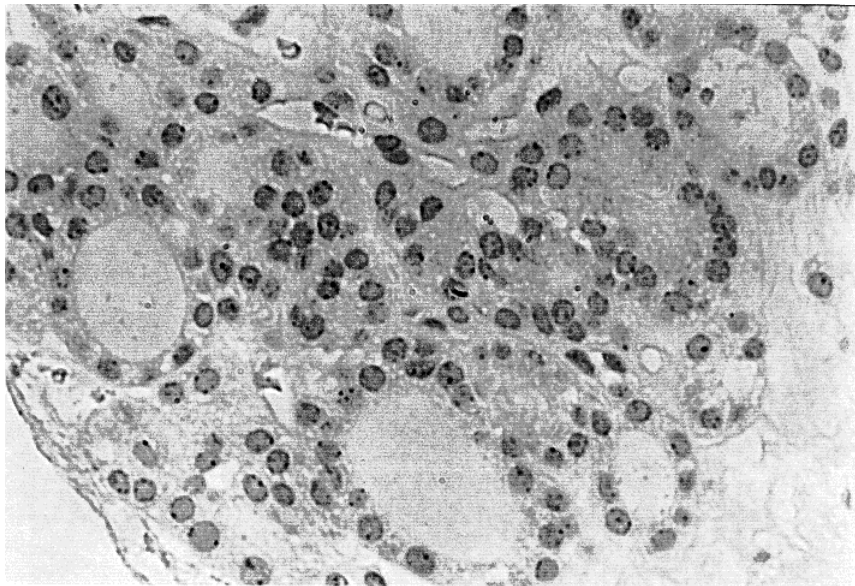
Fig. 4. In situ hybridization technique of a case of an atypical adenoma with capsular invasion (AAI, case no. 43) showing many trisomic cells with chromosome 17 probe.